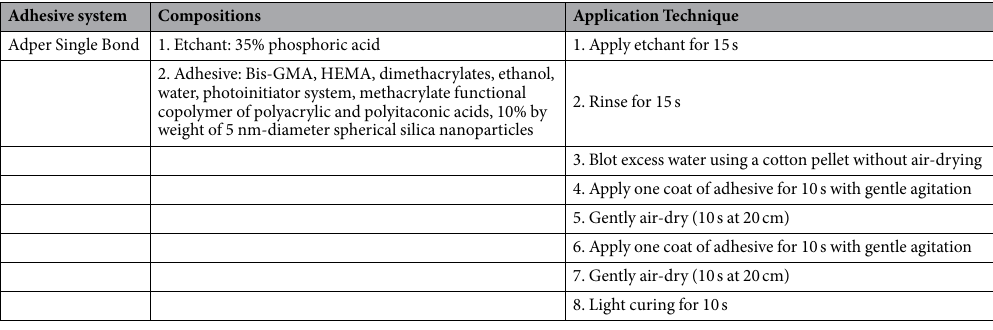
Table 1. Adhesive system, composition, and